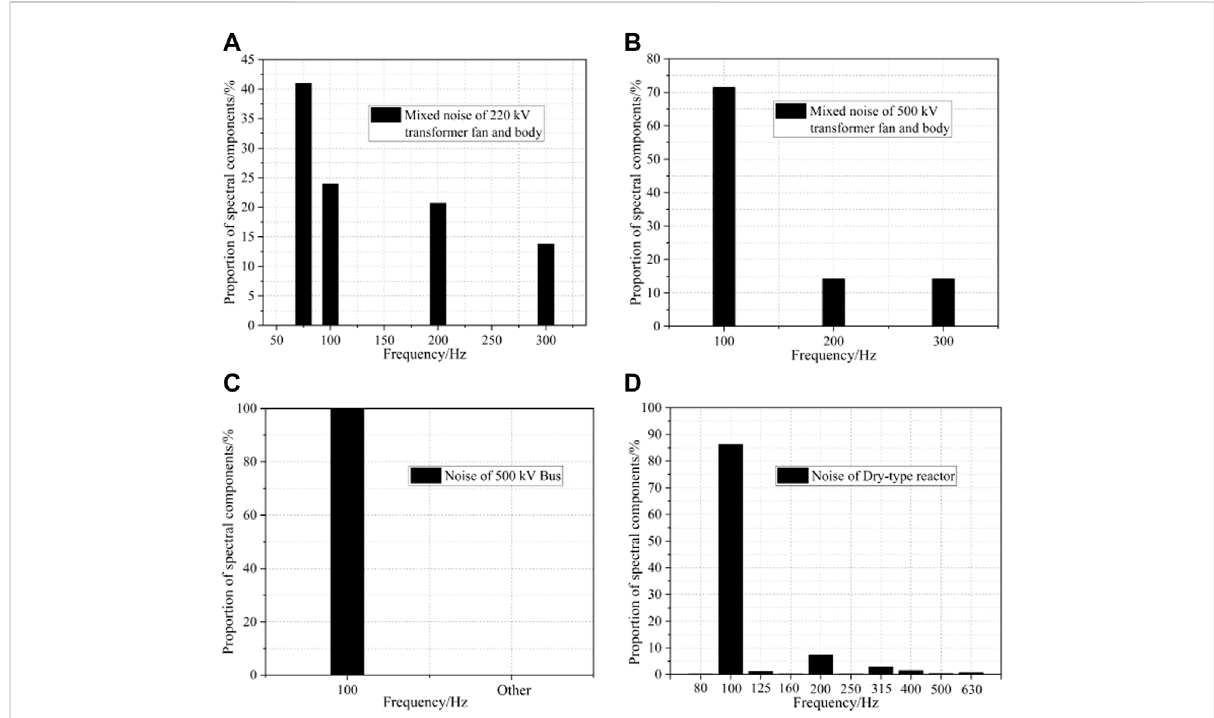
FIGURE 7 Frequency spectrum distribution of operation acoustic signals of the transformer, bus, and dry-type